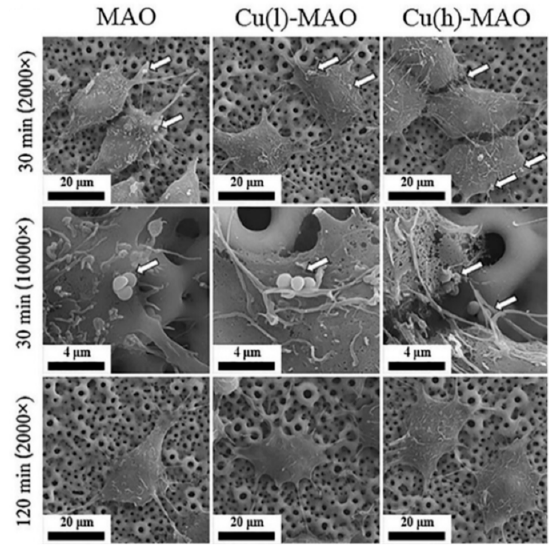
Figure 3. The bactericidal capacity of macrophages in response to material surfaces. The SEM images showing the macrophage/bacteria interactions on different Cu-containing surfaces. Respectively, specimens treated with 0.2 and 2 mM CuSO 4 ·5H 2 O were recorded as Cu(l)-MAO) and 2(Cu(h)-MAO). The white arrows indicate that bacteria are captured by macrophages [35]. Reprinted with permission from reference [35] 2018 Elsevier.